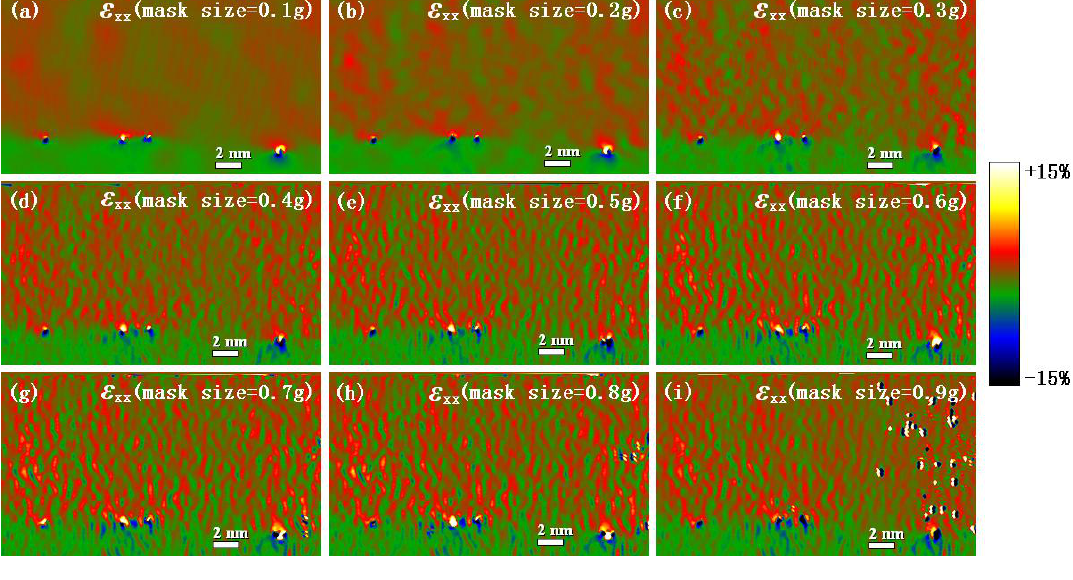
at the Ge/Si heterostructure interface xx